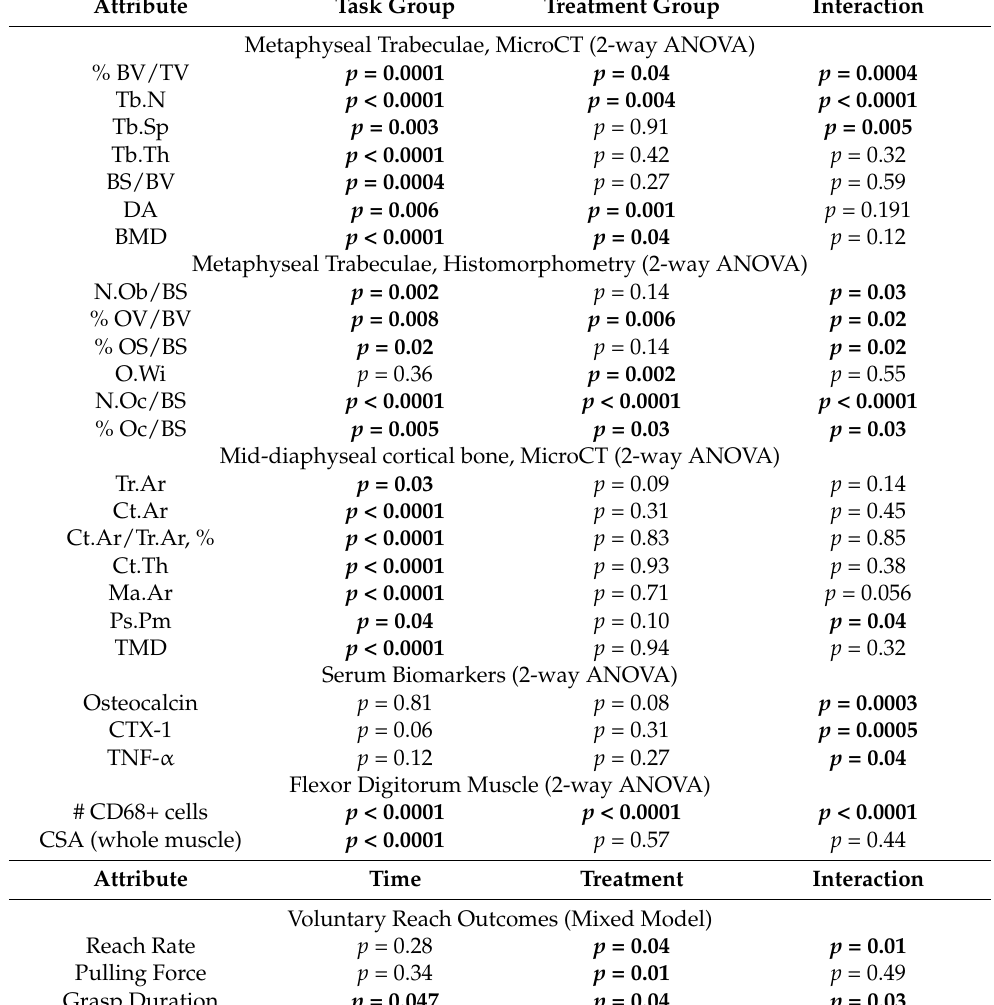
Attribute Time Treatment Interaction Voluntary Reach Outcomes (Mixed Model) Reach Rate p = 0.28 Pulling